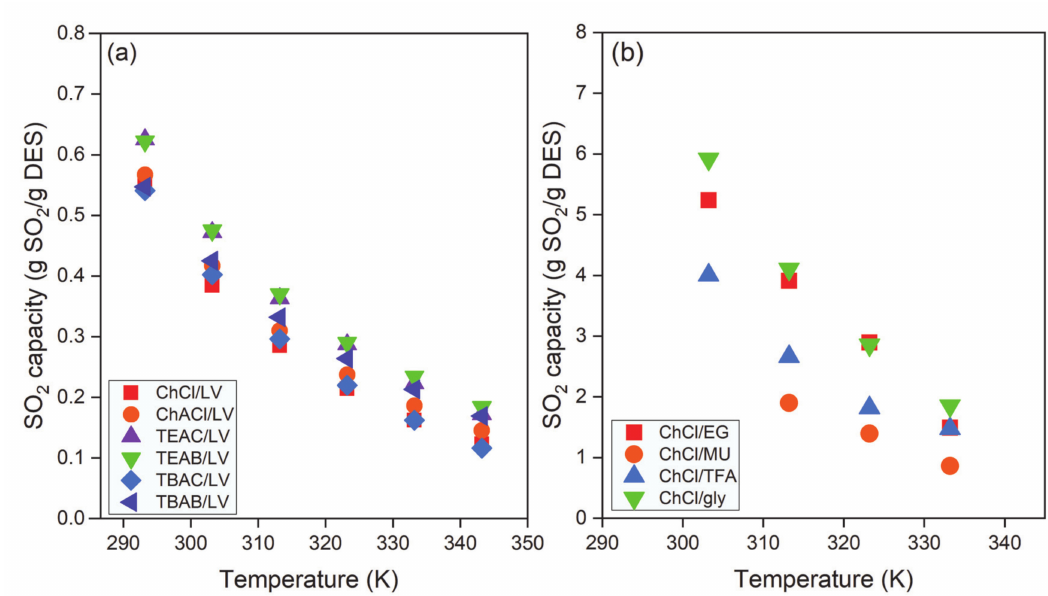
Figure 8. Effect of ( a ) HBA and ( b ) HBD on SO 2 capacity at 0.1 MPa as a function of temperature. Data are extracted from